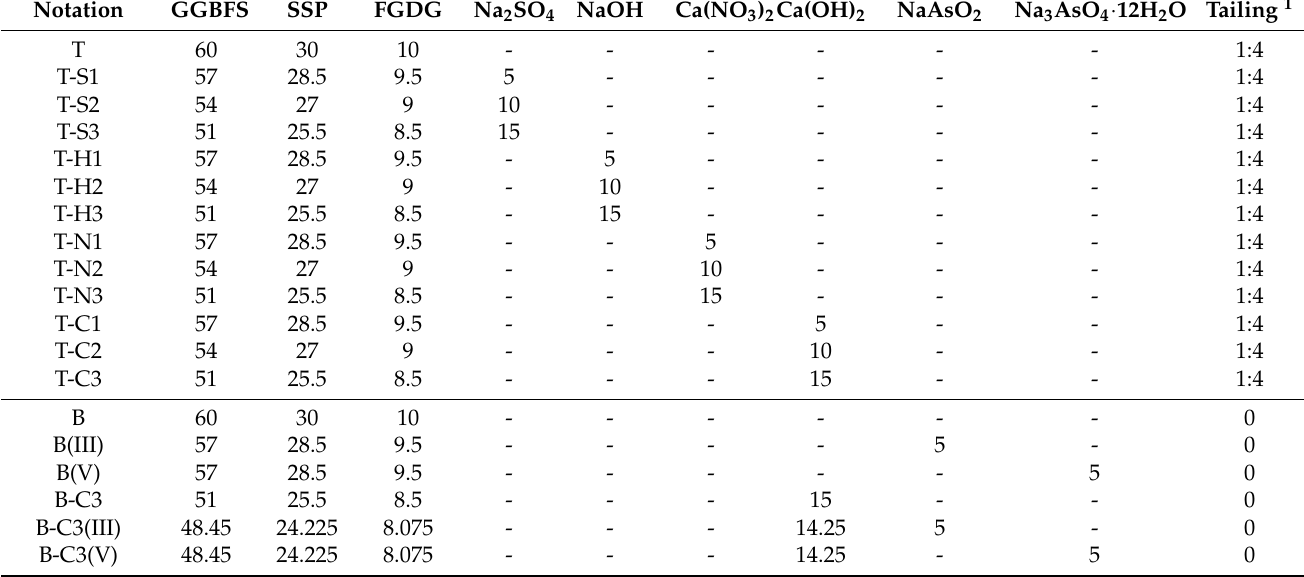
Table 2. Mixture formulations of MST and MSB samples